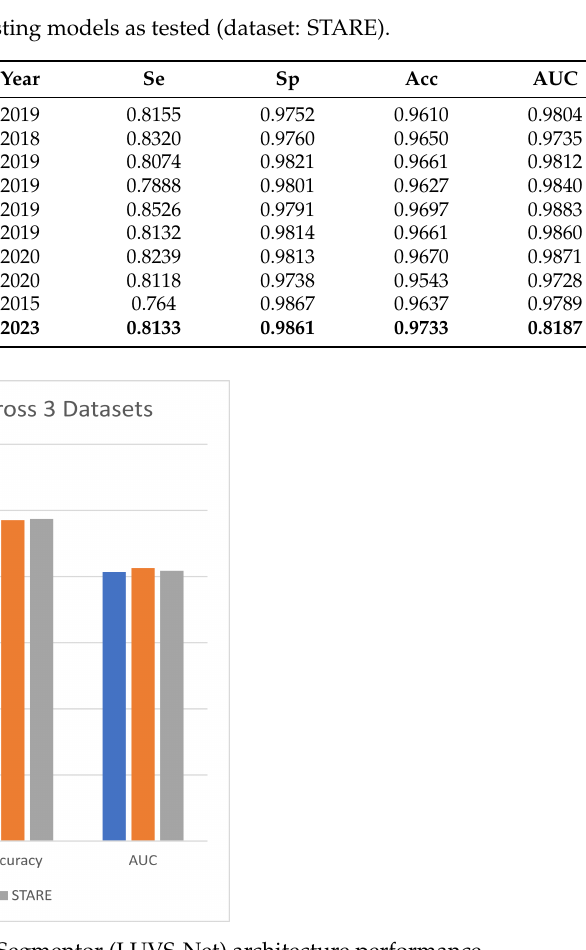
Figure 5. Lightweight U-Net Vessel Segmentor (LUVS-Net) architecture